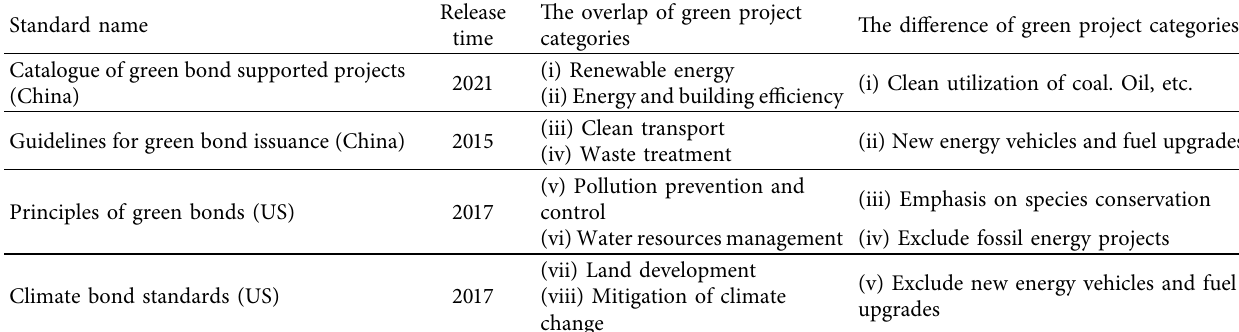
Table 1: Comparison of main green bond standards in China and the United